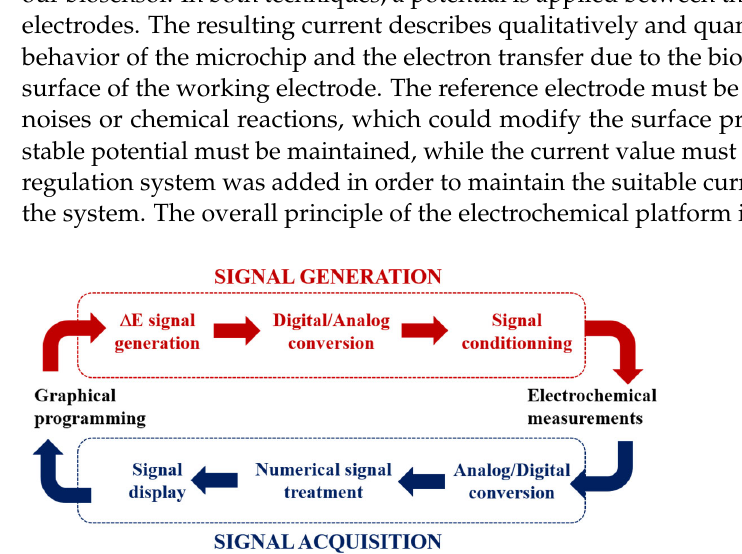
Figure 4. CV and CA processes developed with LabVIEW.